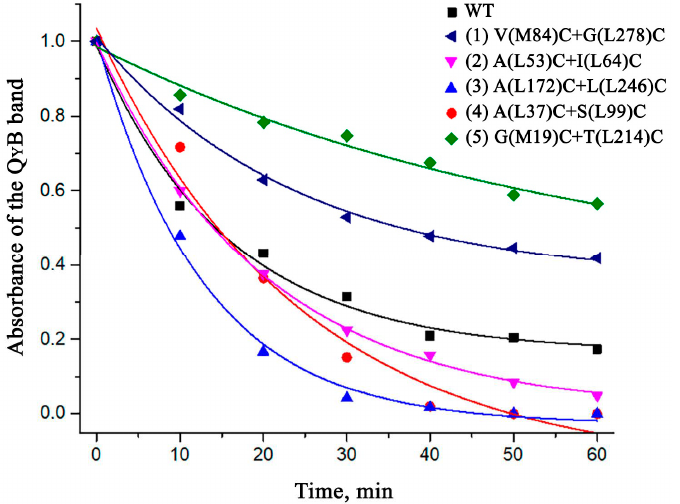
Figure 6. Thermodependent changes in the long-wavelength absorption band of monomeric BChls (at an incubation temperature of 48 ◦